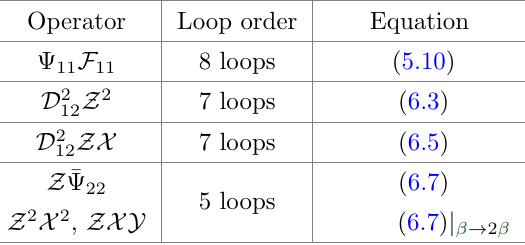
Z 2 is the sl (2) 12